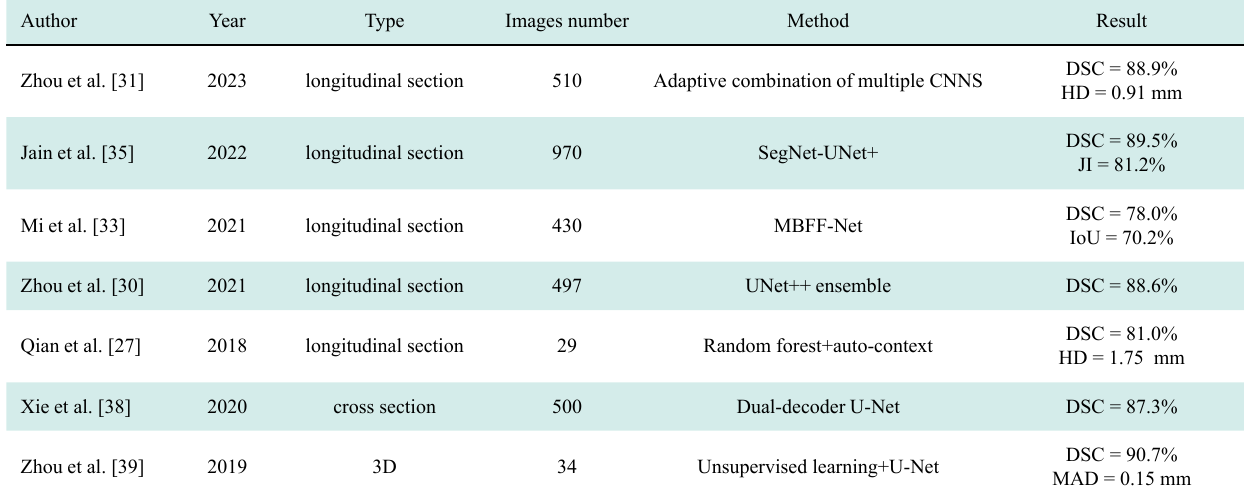
Table 2 Comparison between the plaque segmentation methods in different